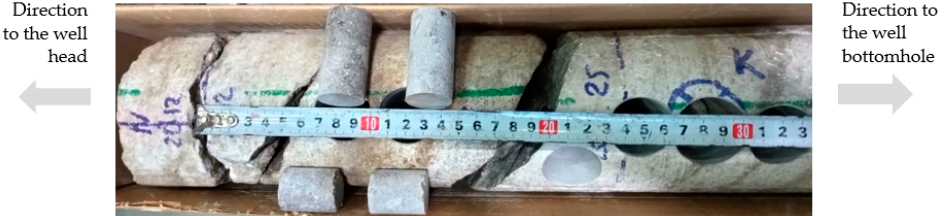
Figure 1. Core extracted from the subsurface while drilling an oil producing well at the field located in the north of the Perm region and limestone samples cut with 25.4 mm diameter diamond bits.